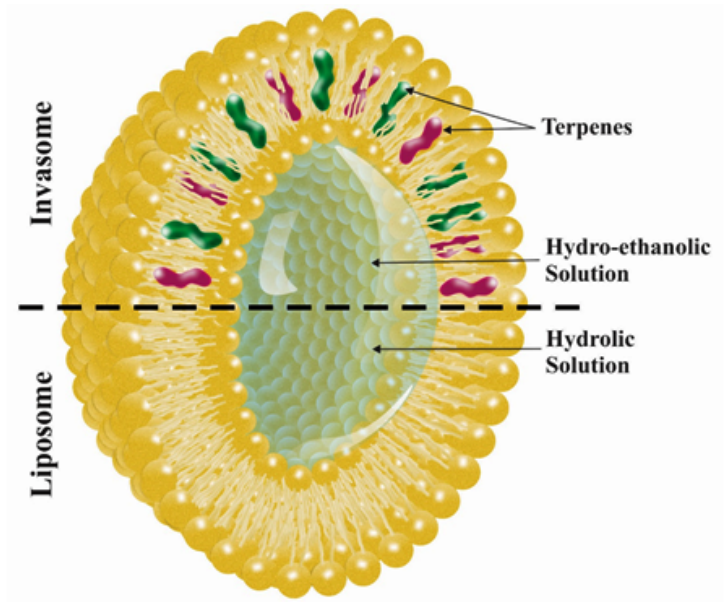
Figure 1. Invasome versus